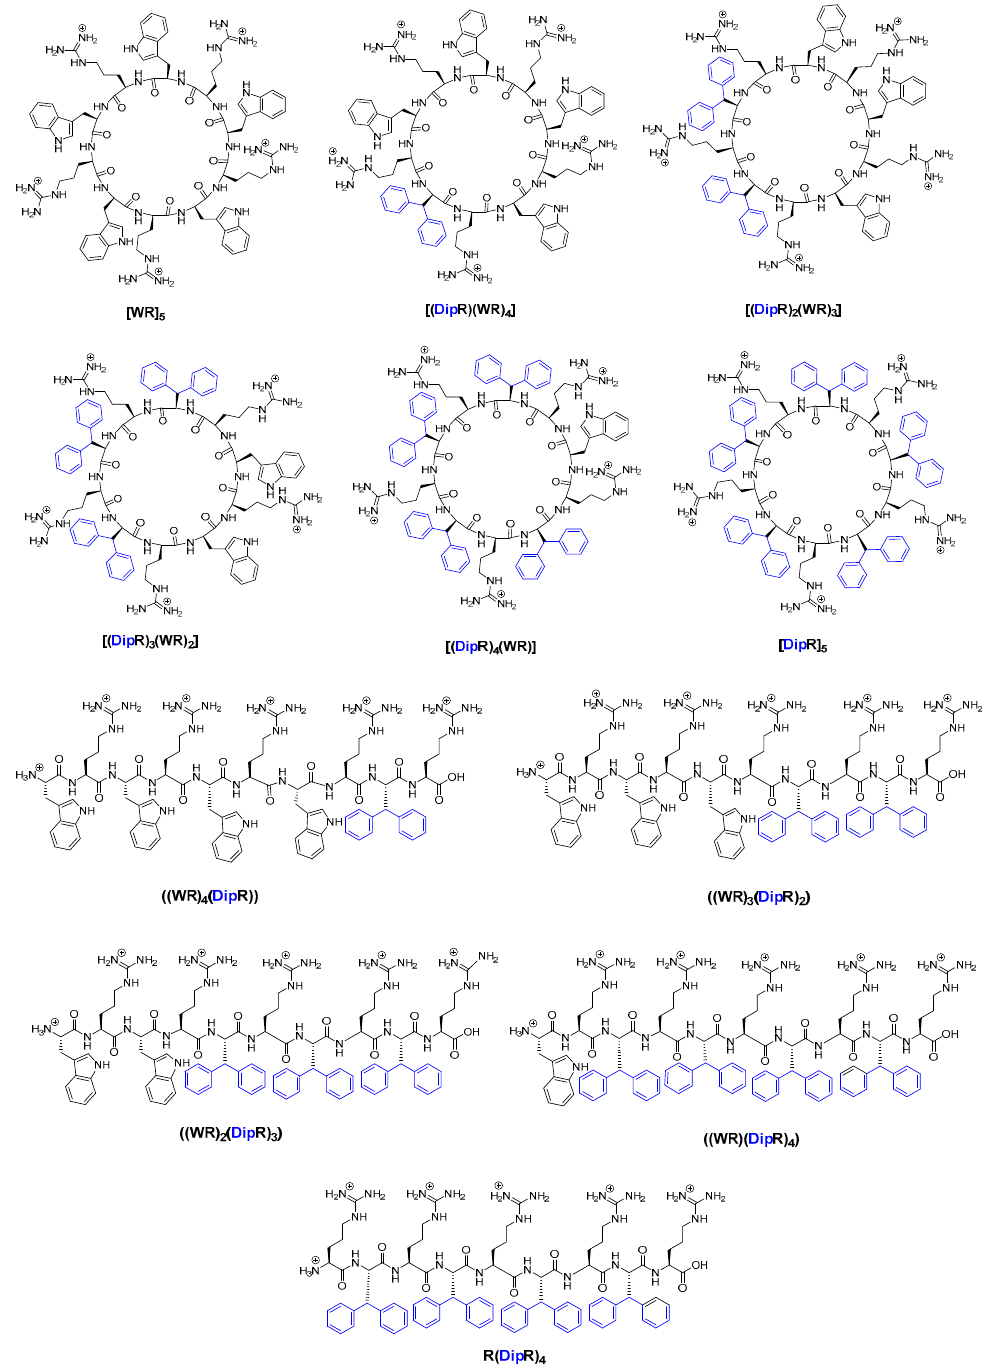
Figure 1. Chemical structures of synthesized cyclic and linear peptides containing R, Dip and/or W residues.